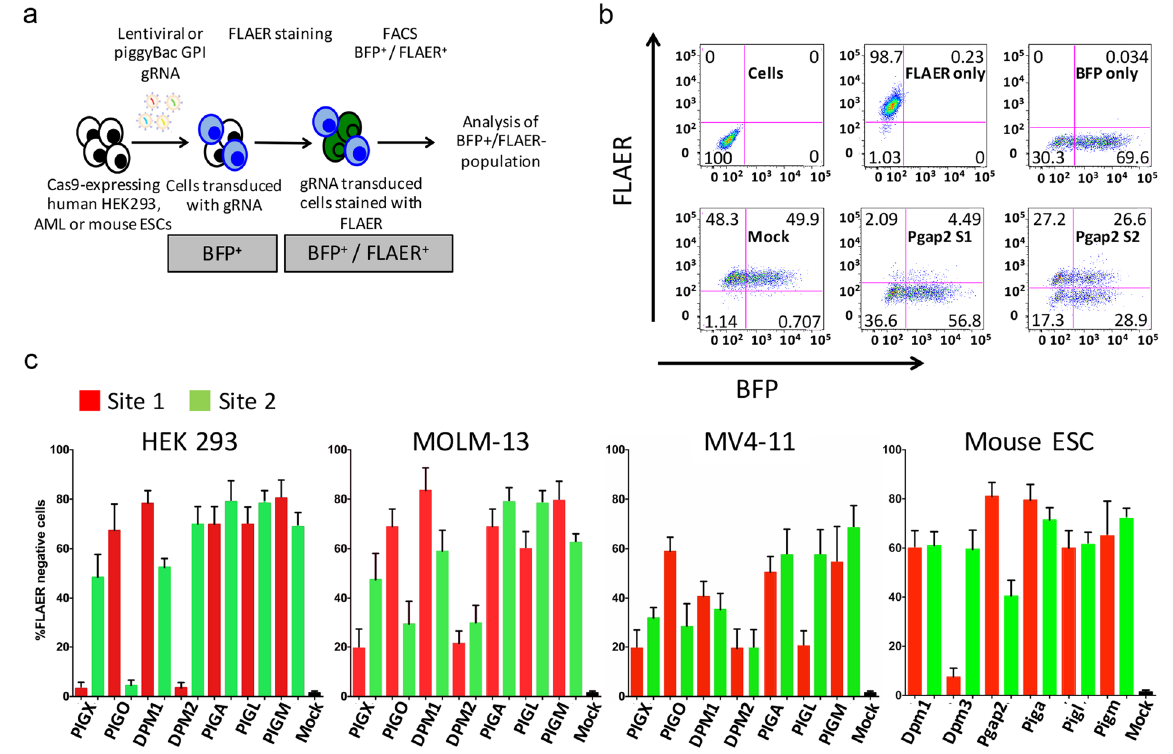
Figure 5. ( a ) Schematic illustrating the experimental design for the GPI anchor protein pathway sgRNA phenotypic evaluation. ( b ) Example of flow cytometry analysis of FLAER stained cells using mouse ES cells transfected with sgRNAs against Pgap2 gene targeting site 1 and site 2. The sgRNA expressing cells were selected with puromycin from 24 hours post transfection and selection was maintained for 2 days. Cells were